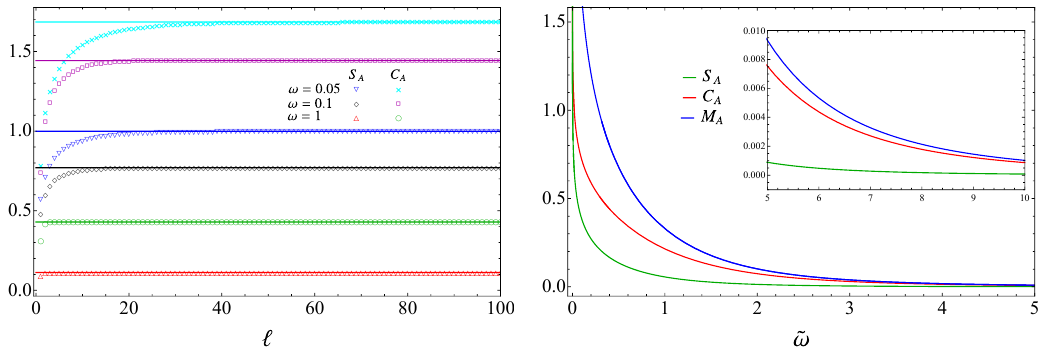
Figure 2 . In the left panel we report S A and C A of an interval in an infinite harmonic chain as a function of the length of the interval ‘ . The solid lines correspond to twice the constants predicted by the CTM calculations (3.11) and (3.12). The curves in the right panel have been obtained from (3.11), (3.12) and